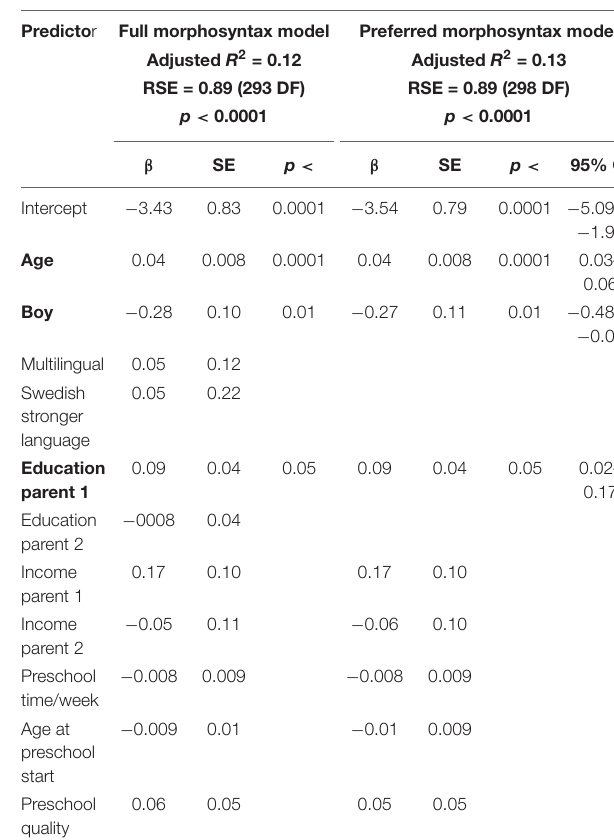
TABLE 4 | Model comparison for morphosyntactic accuracy.